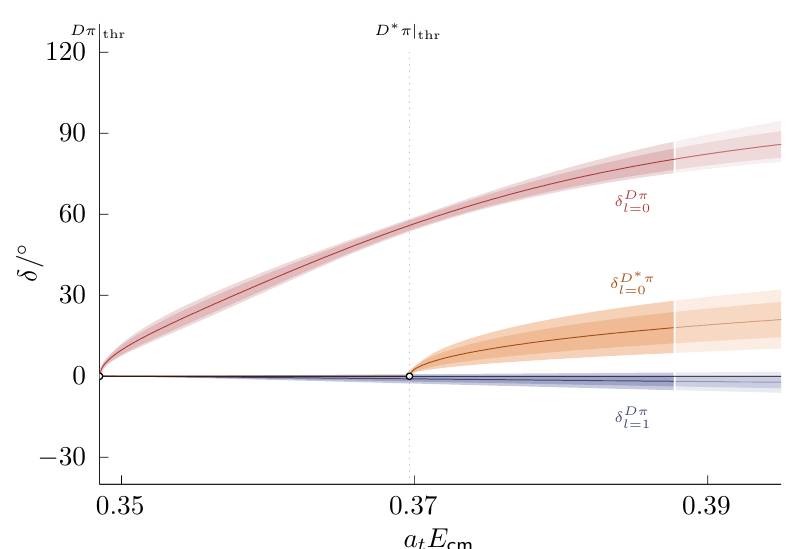
Figure 14. As figure 4, but for phase shifts of Dπ in S -wave (red) and P -wave (blue), and D ∗ π in S-wave (orange) corresponding to eq.